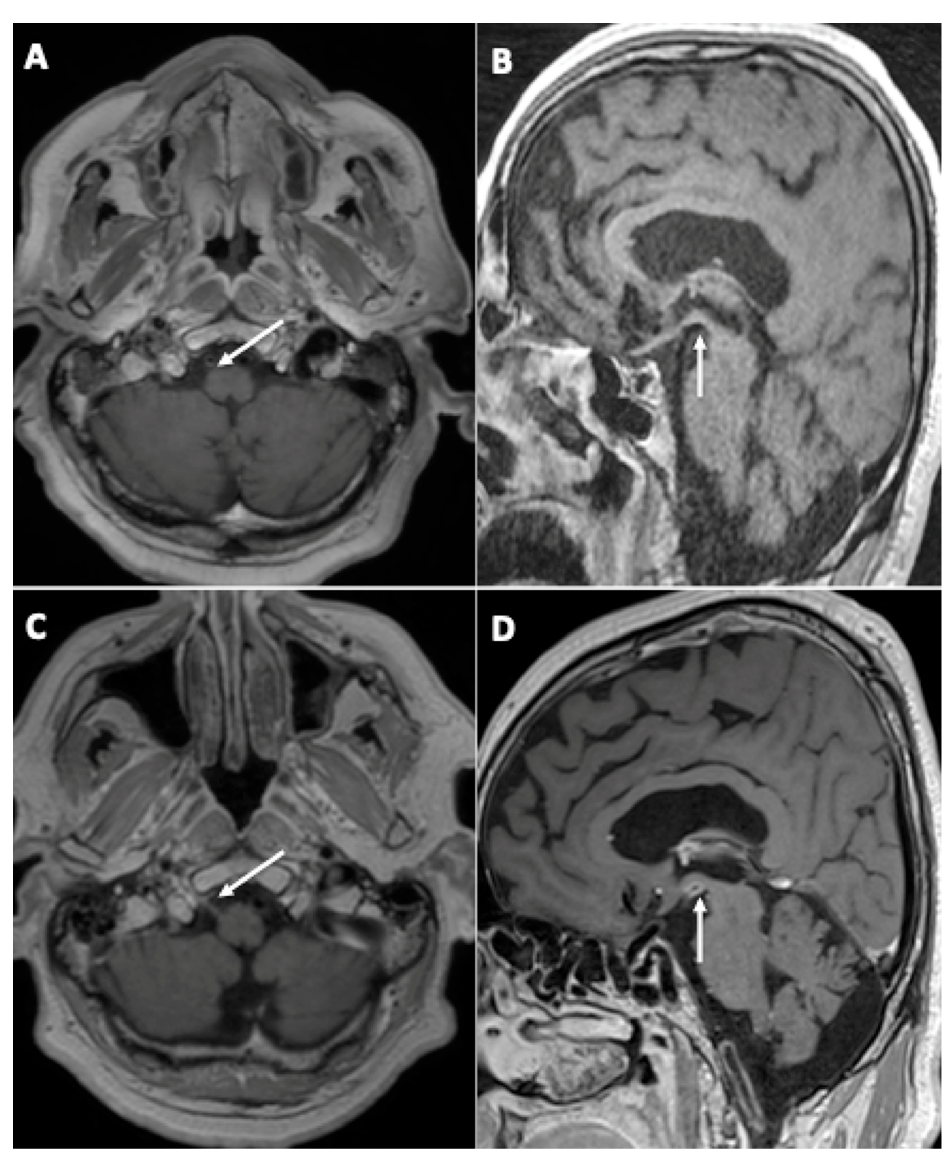
Figure 3. A 67-year-old man (#20) ( A , C ) and a 61-year-old man (#7) ( B , D ), both initially hospitalized (ICU), who each underwent a second MRI during follow-up 112 ( A , C ) and 99 ( B , D ) days later, re- spectively. Axial ( A , C ) and sagittal ( B , D ) post-contrast three-dimensional T1 weighted spin-echo MR imaging. Appearance of contrast enhancement affecting the right hypoglossal nerve ( C ) (neuri- tis), and the wall of the posterior cerebral arteries suggestive of cerebral vasculitis. (d) Evolution of perfusion imaging Among the 31 patients, 24 underwent at least two assessable arterial spin labeling (ASL) brain perfusion imaging at different timepoints, none of them with an intracranial arterial occlusion on MR-angiography. Among these 24 patients, 19 (79%) had abnormal brain perfusion on the initial imaging: 16 (66.7%) patients had hypoperfusion (Figure 4)